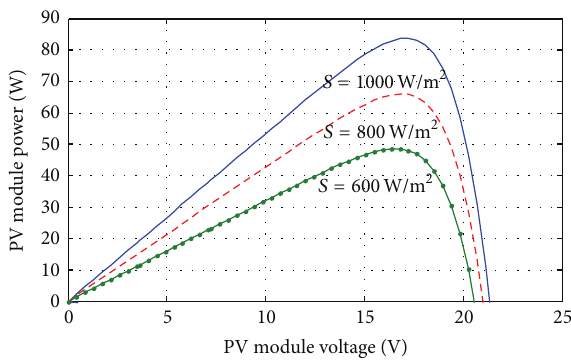
Figure 4: KOYCERA KC85T-87W PV model P-V characteristics curve with varying irradiation.